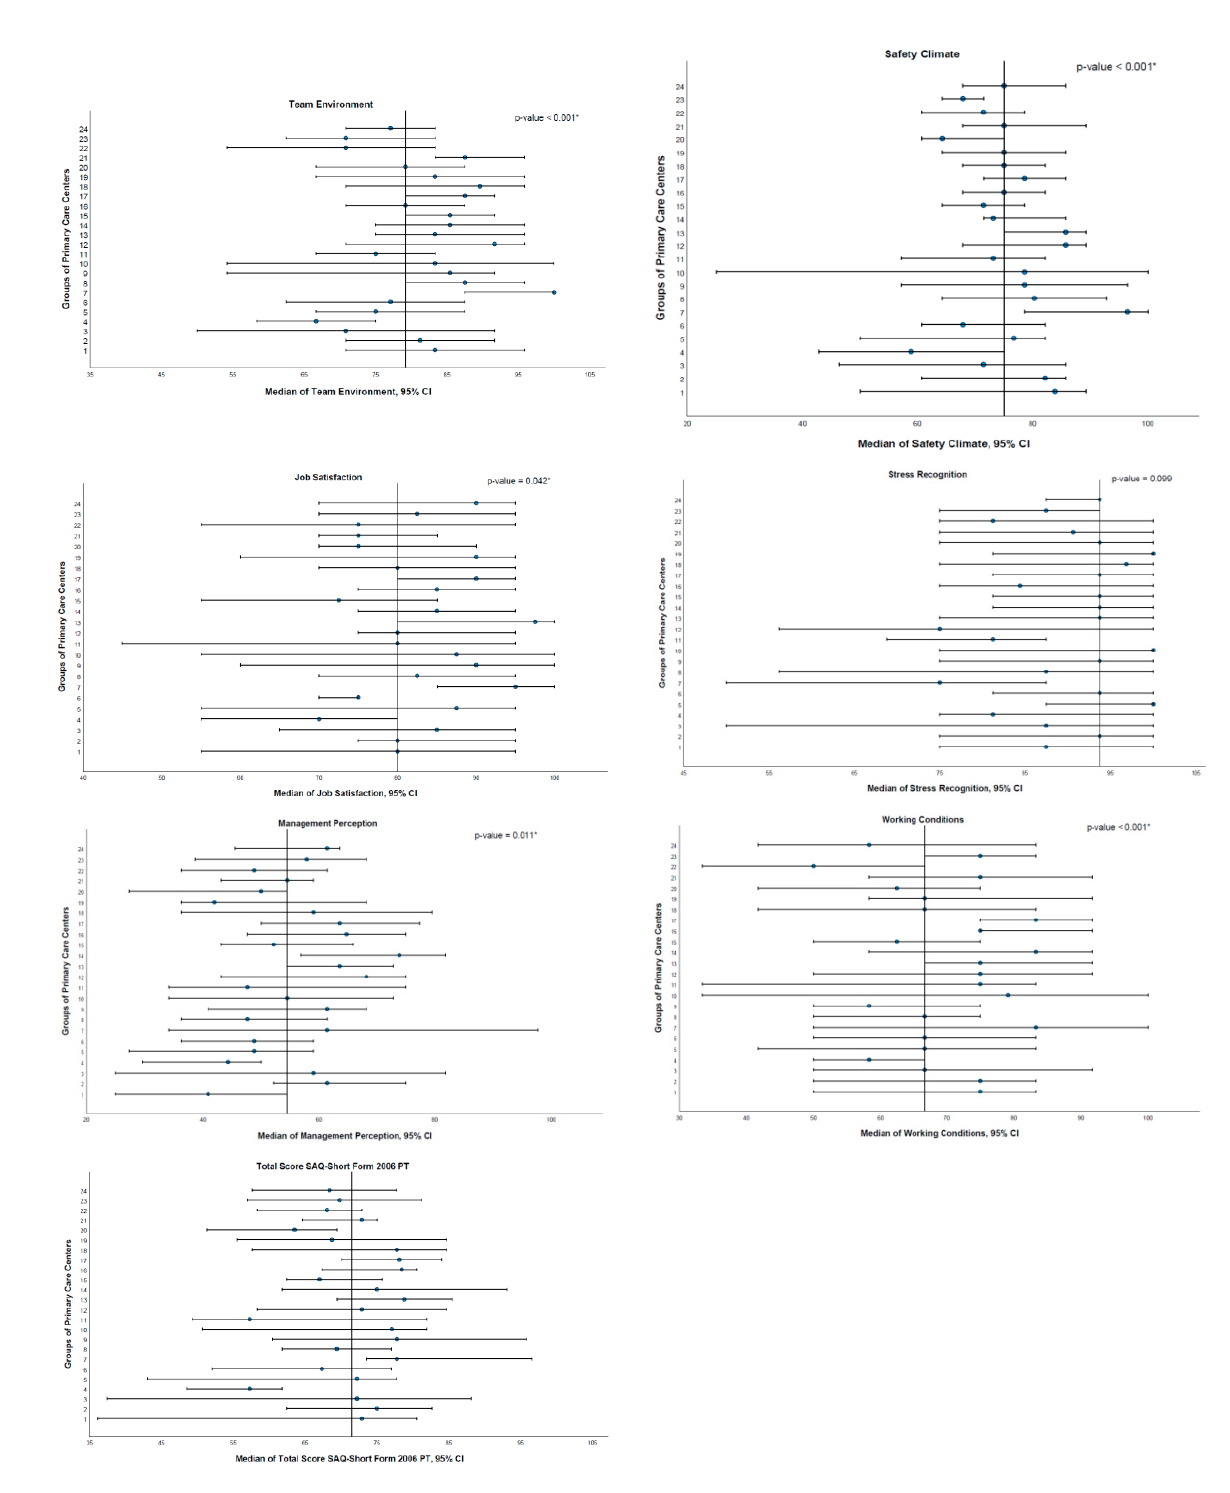
Figure 2. Medians and respective 95% CI of the six domains and total SAQ-Short Form 2006 PT score by ACeS. The Kruskal–Wallis test was used. *: significant at 5%.